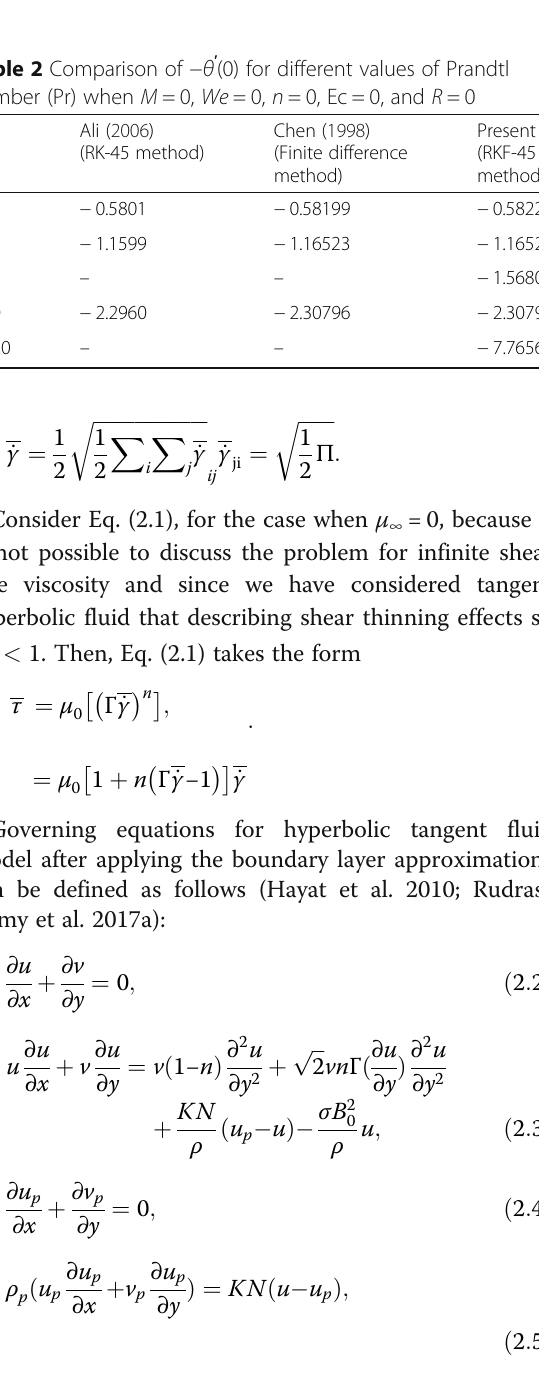
Present result (RKF-45 method)